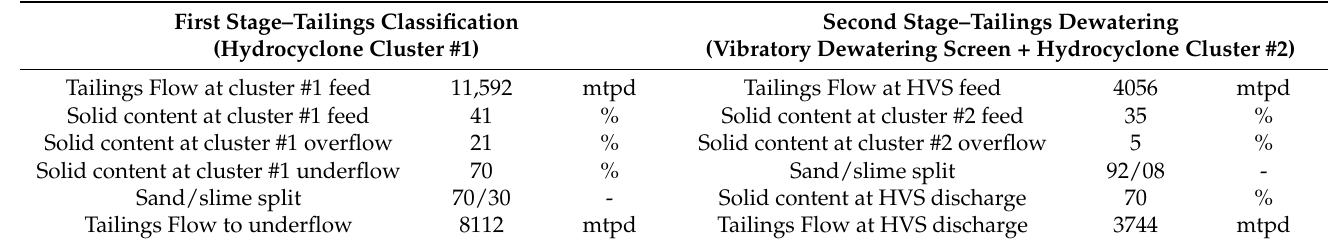
Table 1. Process Performances and Results–1st Tailings Dewatering Industrial Plant